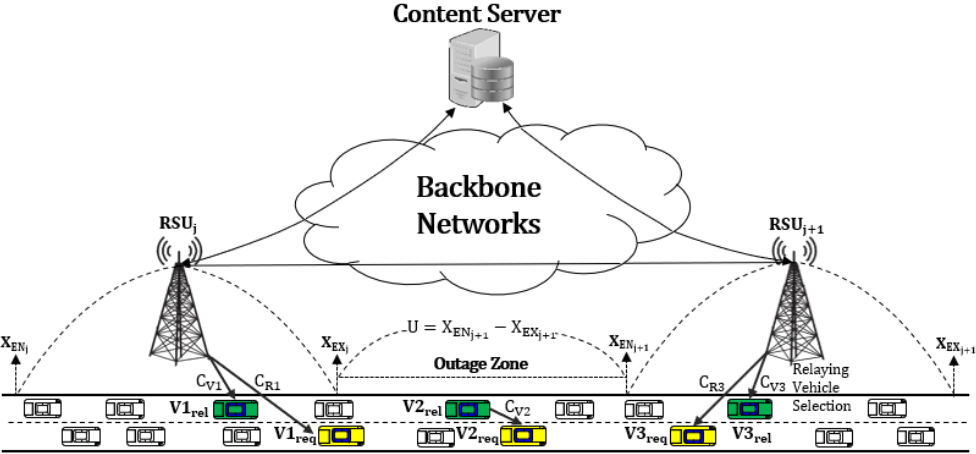
Figure 1. The network model and the overview of the proposed